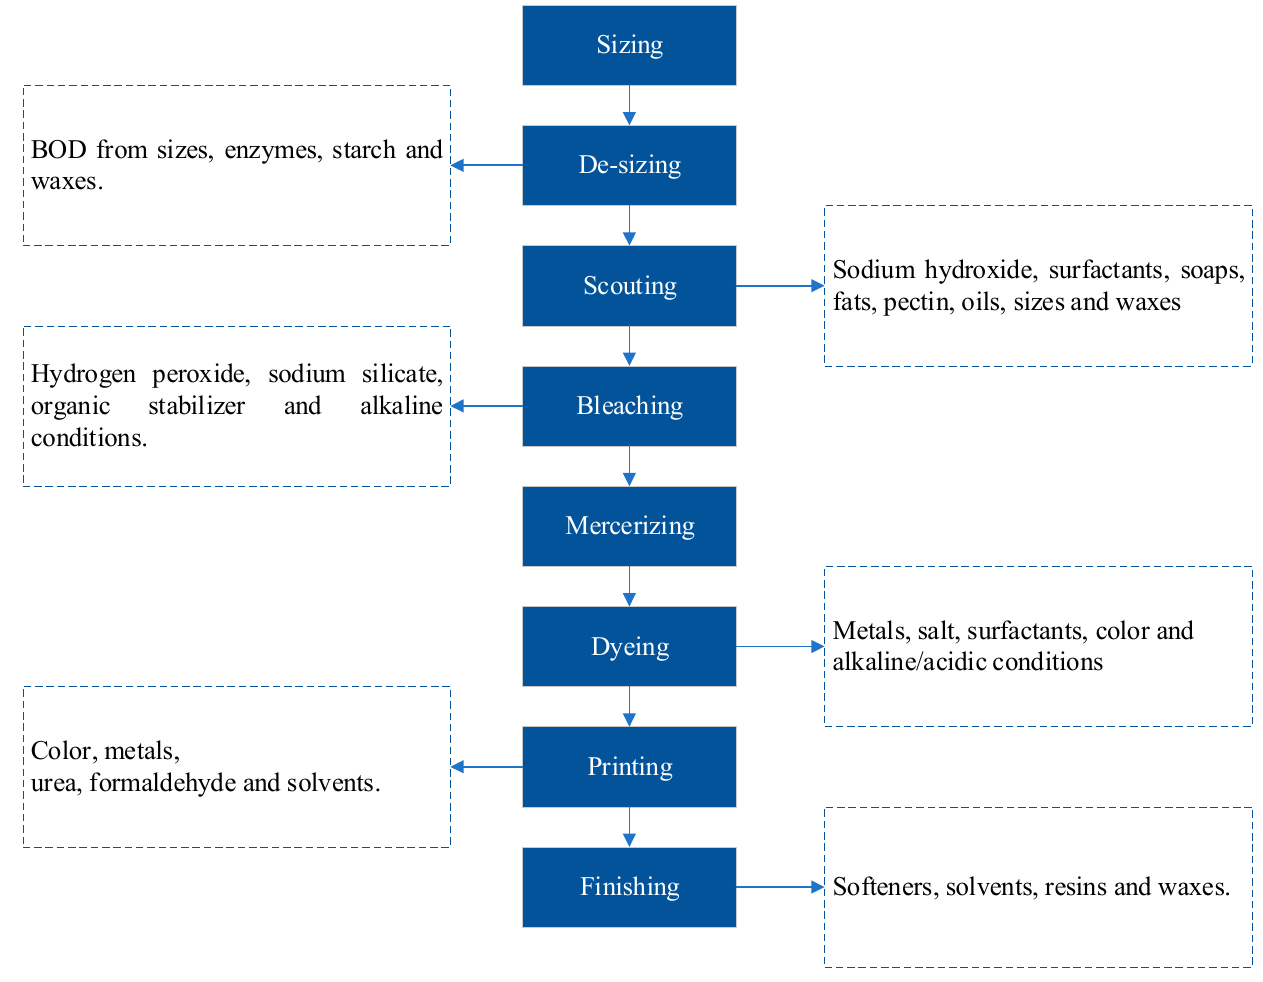
Figure 6. General textile industry production processes.